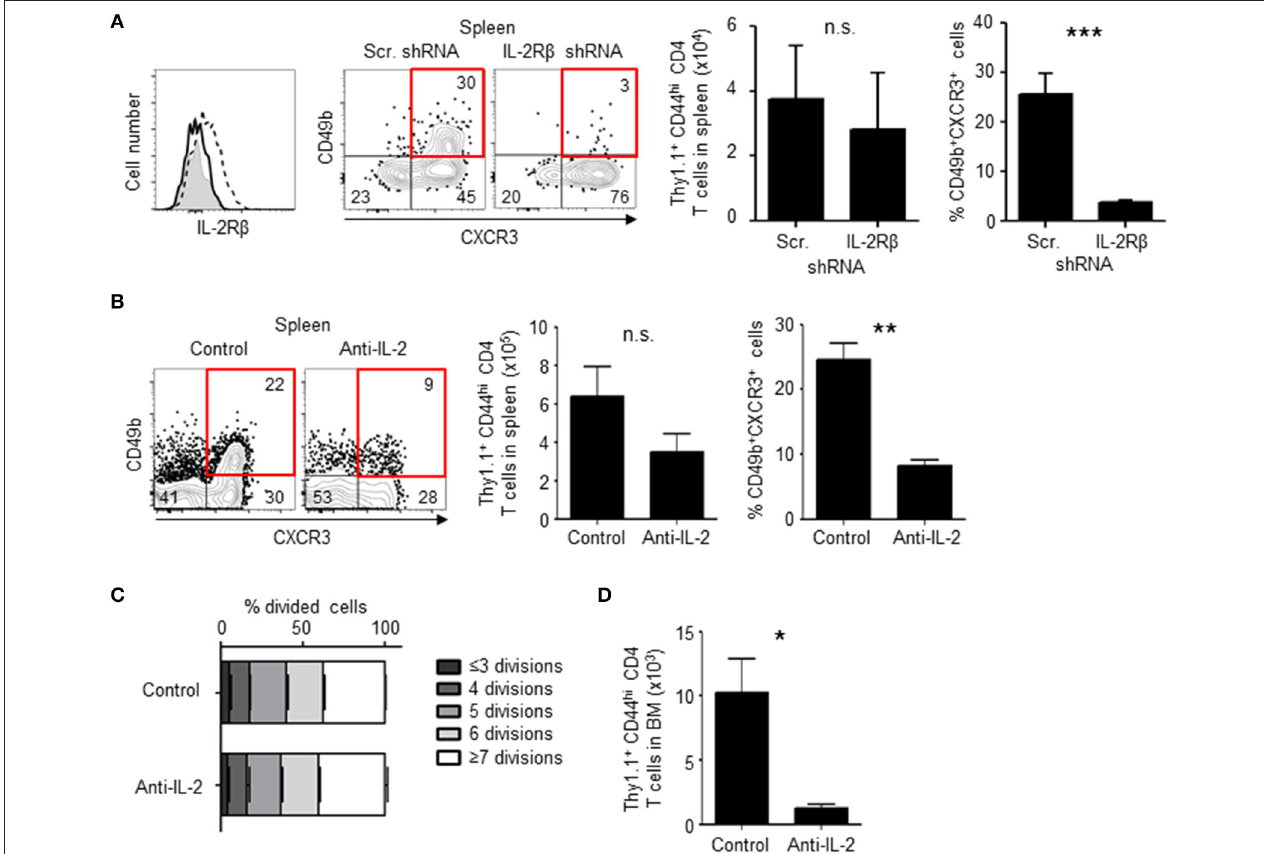
FIGURE 6 | Loss of IL-2 signal inhibits the differentiation of BM memory precursors. (A) Knock-down of IL-2R β reduces numbers of CD49b + CXCR3 + memory precursors. C57BL/6 mice were transferred with preactivated and IL-2R β shRNA- or scrambled (Scr.) shRNA-transduced Thy1.1 + LCMV GP-specific CD4T cells, immunized with LCMV-gp61 and LPS and analyzed on day 6 after immunization by flow cytometry. The histogram shows the efficiency of IL-2R β shRNA-mediated knock-down (filled histogram, isotype control; dashed line, Scr. shRNA; solid line, IL-2R β shRNA) and the dot plots show the expression of CD49b and CXCR3 in Thy1.1 + CD44 hi CD4 + B220 − NK1.1 − PI − cells. The bar charts display the numbers of total Thy1.1 + LCMV GP-specific CD4T cells (left) and the frequency of CD49b + CXCR3 + subpopulation (right) n = 6. (B–D) Injection of anti-IL-2 reduces numbers of CD49b + CXCR3 + memory precursors. As described in Figure 1 , C57BL/6 mice were transferred, immunized and analyzed by flow cytometry on day 6 after immunization, receiving 1mg of anti-IL-2 or isotype control on days 0, 2, and 4. The dot plots show the expression of CD49b and CXCR3 in Thy1.1 + CD44 hi CD4T cells. The bar charts display the numbers of total Thy1.1 + CD4T cells ( B , left) and the frequency of CD49b + CXCR3 + subpopulation ( B , right), the dilution of CFSE in each subpopulation in the spleen (C) and the BM (D) n = 4. These data are representative of two independent experiments. Data are shown as mean ± SD. * p < 0.05, ** p < 0.01, *** p < 0.001, n.s.: not